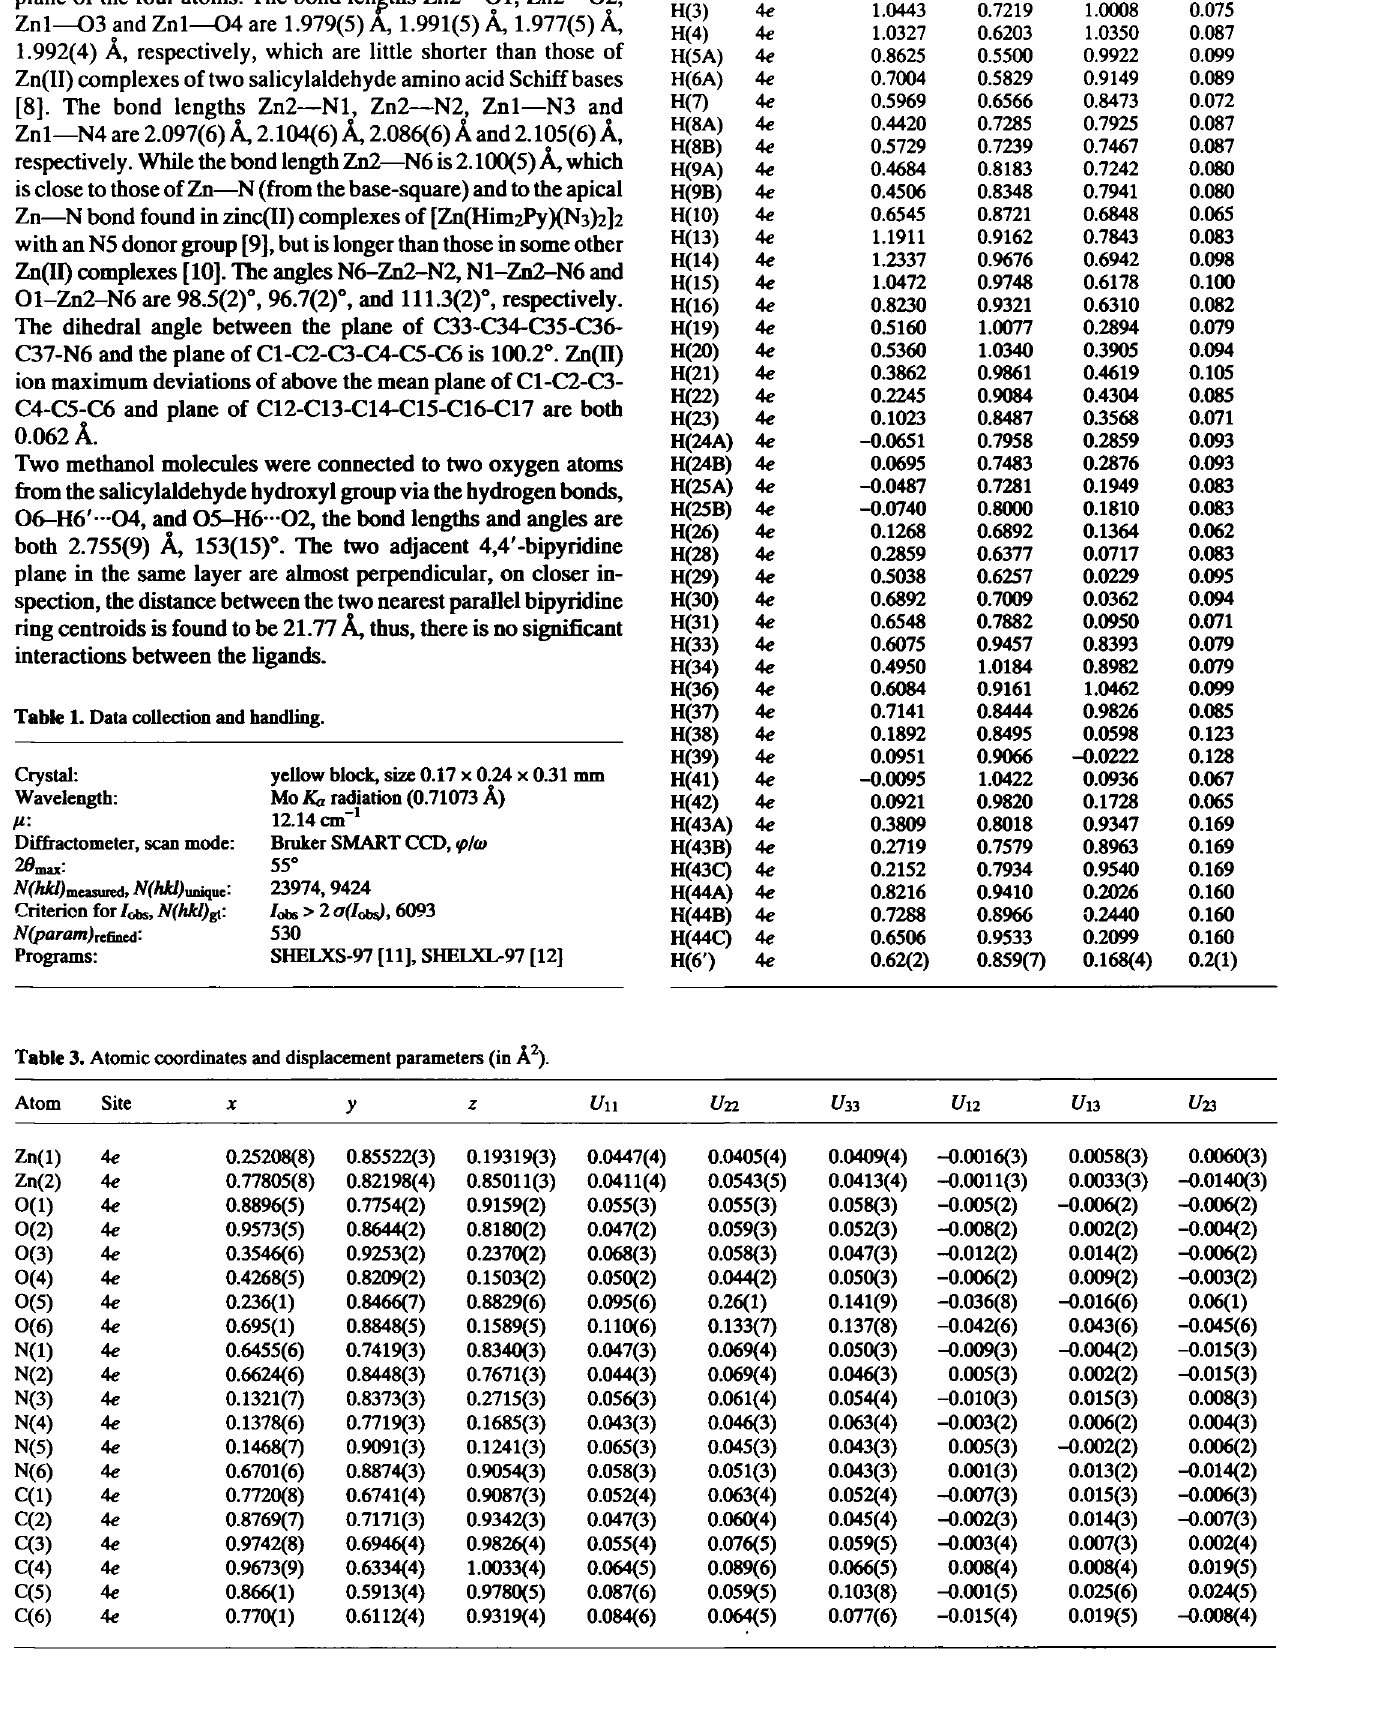
Table 2. Atomic coordinates and displacement parameters (in A 2 ).